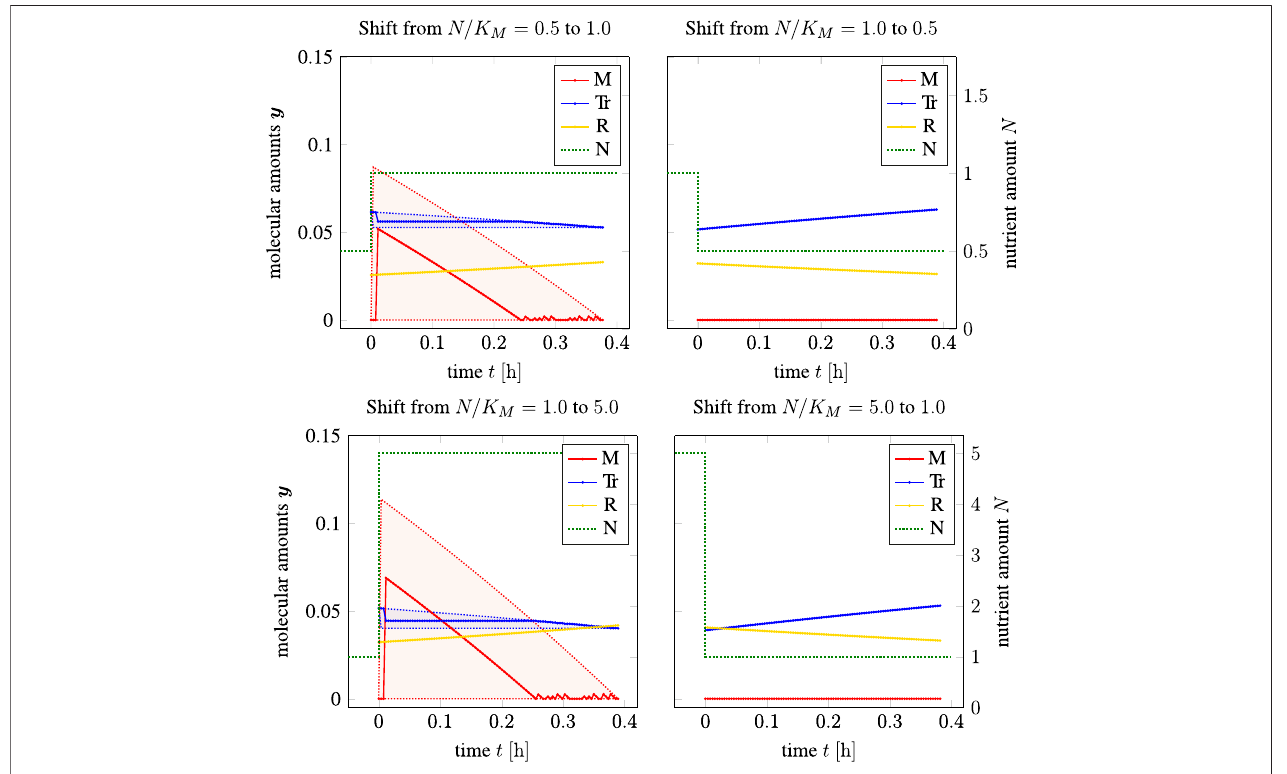
FIGURE7| Adaptationtoasinglenutrientjump(shownasadashedgreenline),leftcolumn:adaptationsfrompoorertorichermedium,rightcolumn:adaptationto scarcer environment; shaded areas: solutions in the sense of TOA-VA. We note that for t < 0, TOA makes no assumptions about y ( t ).